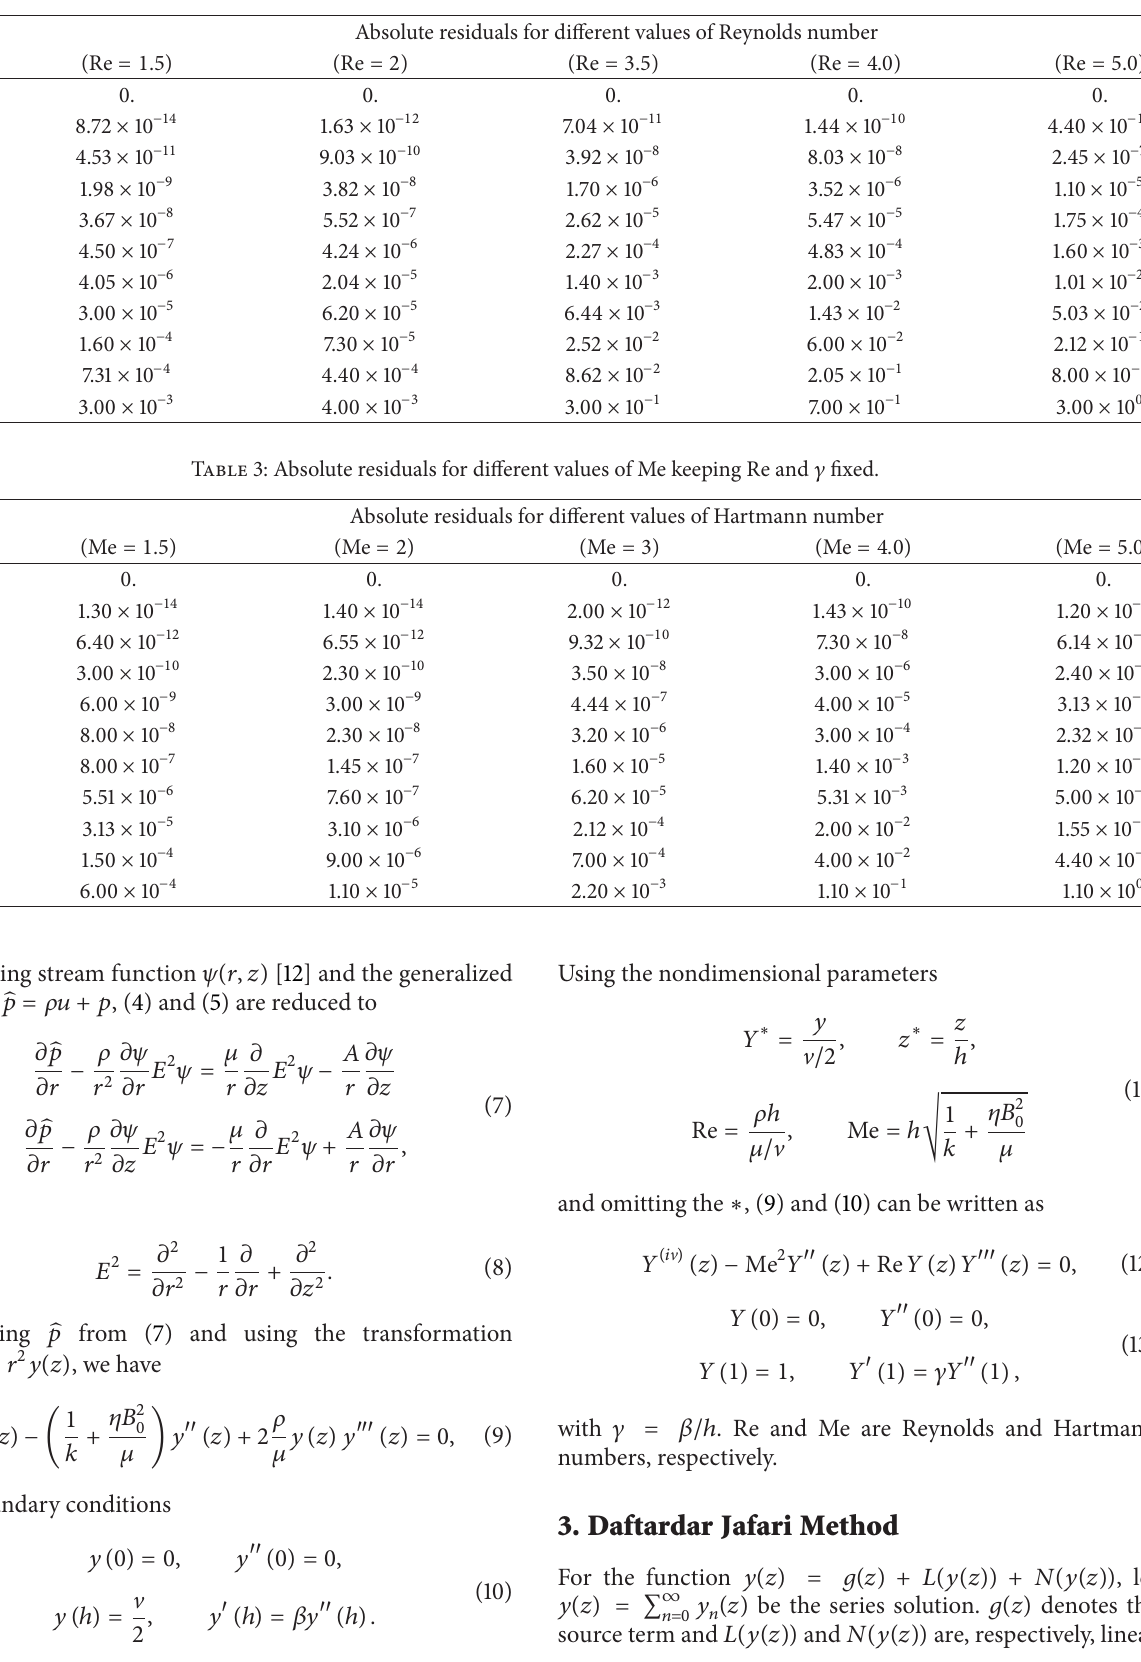
Table 2: Absolute residuals for different values of Re keeping Me and 𝛾 fixed.